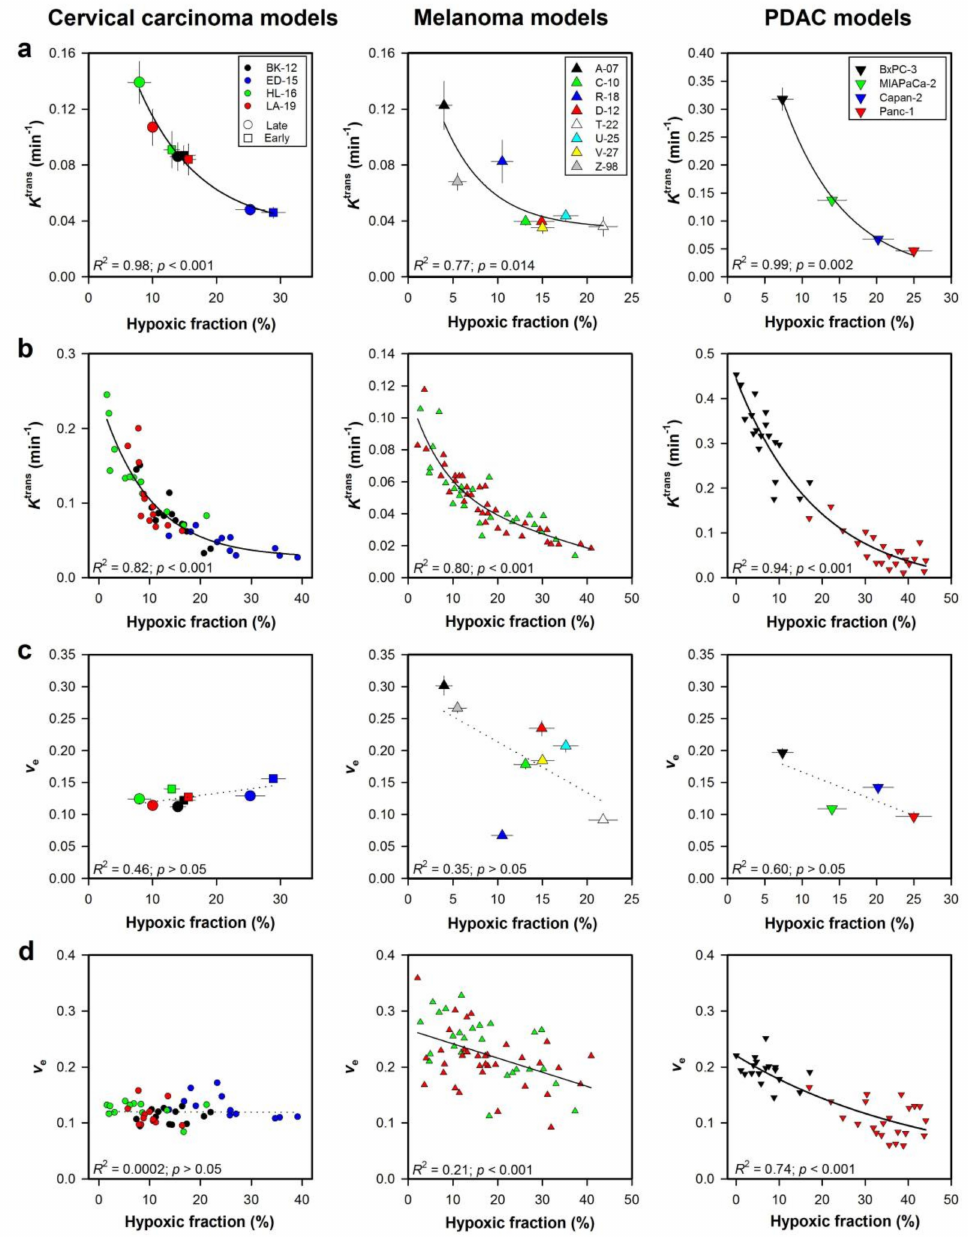
Figure 3. Xenografted tumors were subjected to DCE-MRI before the fraction of hypoxic tumor tissue was determined by immunohistochemistry. The figure shows K trans versus hypoxic fraction ( a , b ), and v e versus hypoxic fraction ( c , d ) in early and late passages of BK-12, ED-15, HL-16, and LA-19 cervical carcinoma xenografts, A-07, C-10, R-18, D-12, T-22, U-25, V-27, and Z-98 melanoma xenografts, and BxPC-3, MIAPaCa-2, Capan-2, and Panc-1 pancreatic ductal adenocarcinonma (PDAC) xenografts. Hypoxic fractions were measured in histological preparations by using pimonidazole as a hypoxia marker. Points represent mean of 9–28 tumors ( a , c ) or individual tumors ( b , d ). Bars represent SEM ( a , c ). Exponential and linear curves were fitted to the data by regression analysis. p -values were obtained by Pearson product moment correlation test. Modified from Hauge et al. [25], Egeland et al. [20], Øvrebø et al. [36], Wegner et al. [24], and Wegner et al.